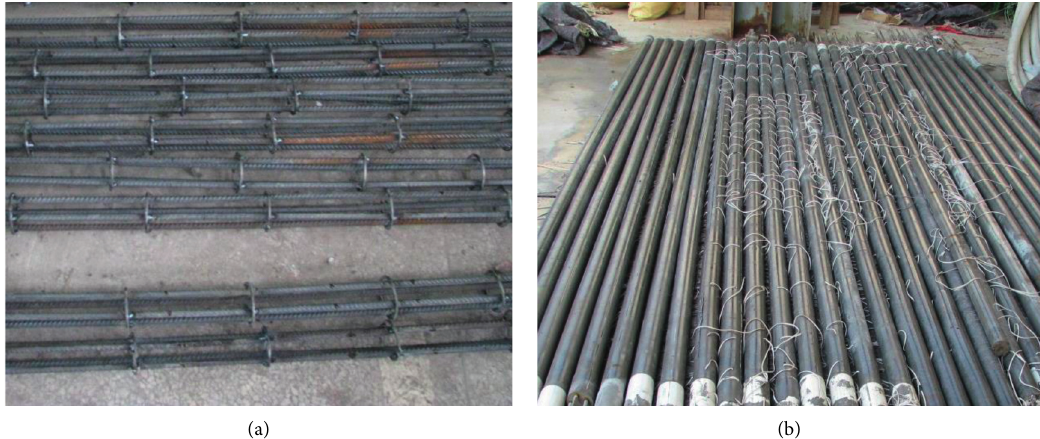
Figure 4: The precast reinforcement concrete micropiles: (a) Reinforcement; (b) micropiles.